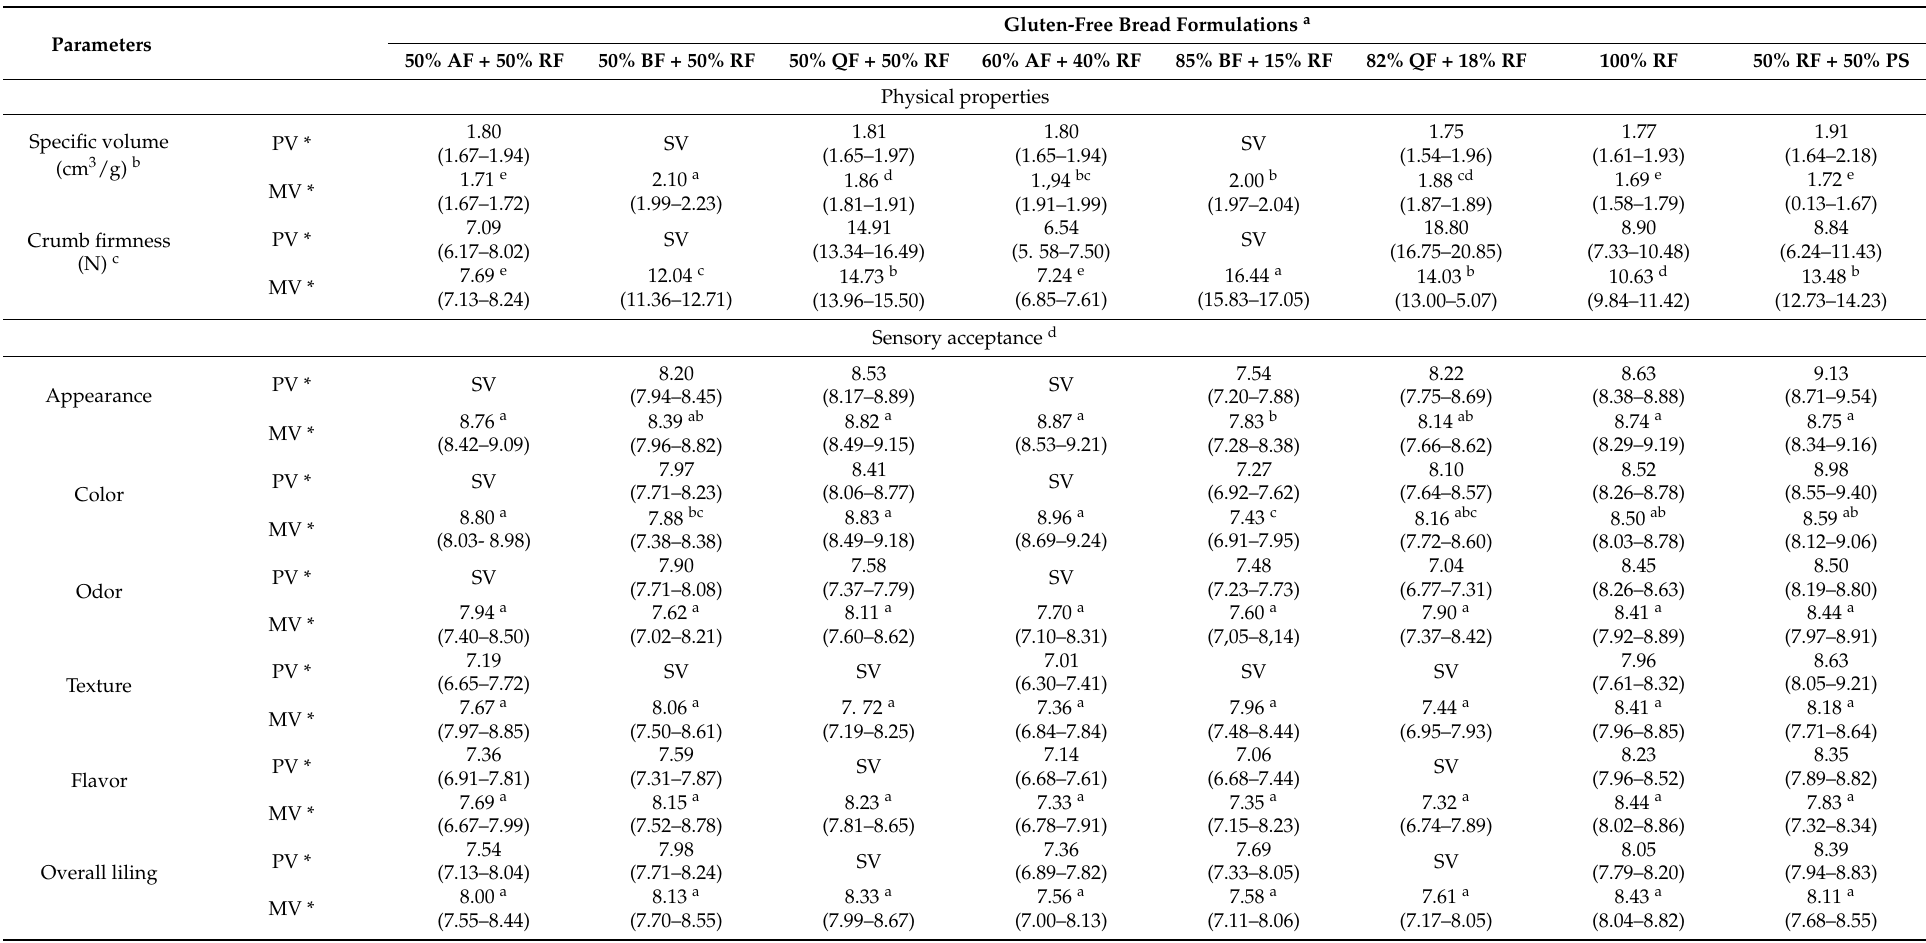
Table 2. Predicted and measured values to physical properties and sensory analysis of the selected gluten-free bread